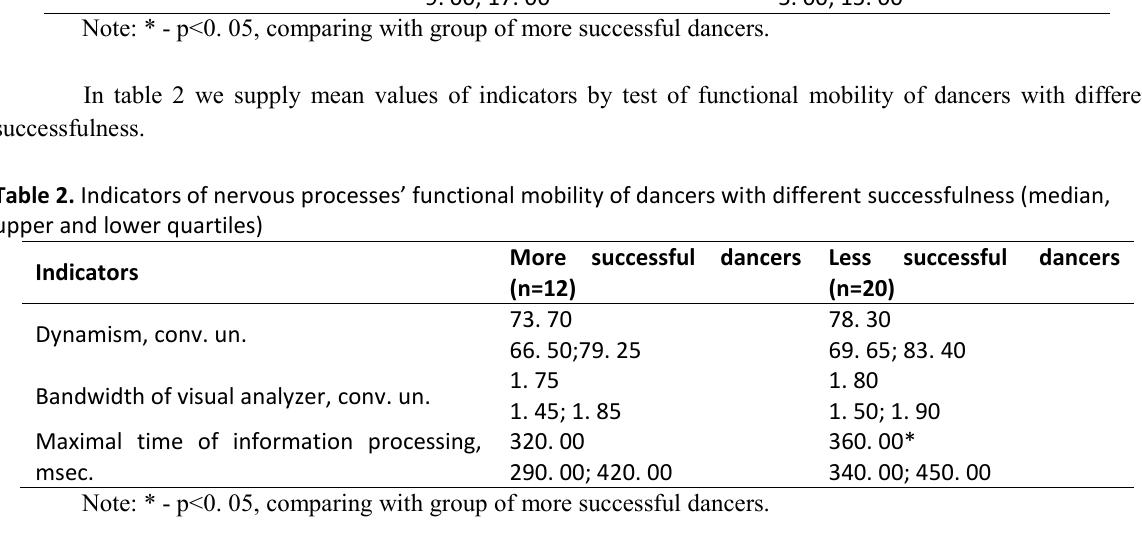
Table 1. Indicators of psychic state by Luscher test of dancers with different successfulness level (median of upper and lower quartiles) Indicators More successful dancers (n=12) Less successful dancers (n=20) Workability, conv. un. Fatigue, conv. un. Anxiety, conv. un. Vegetative coefficient, conv. un. .